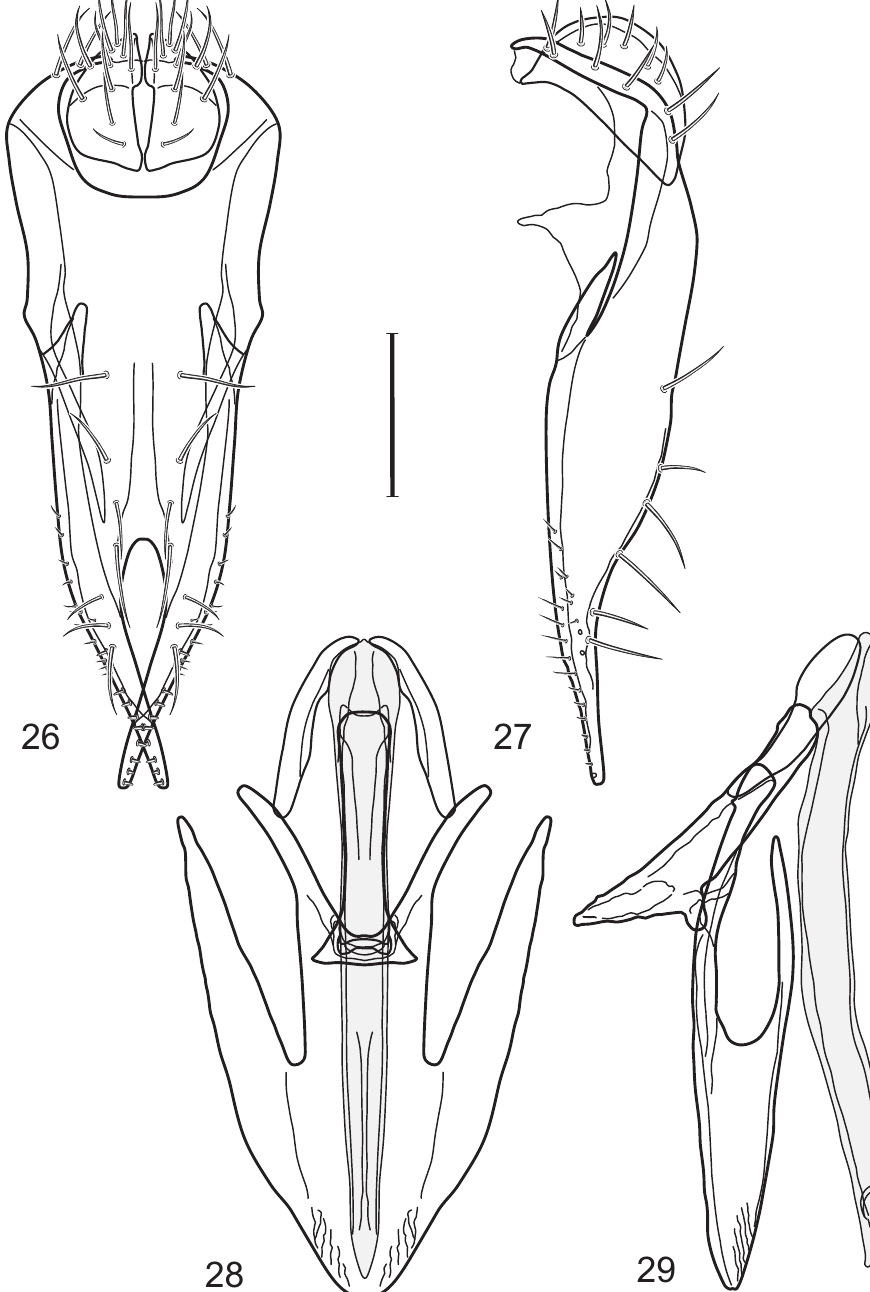
Figures 26–29. Hydrochasma patens Cresson (Chile. Talca: Rio Lircay, 11 km N Talca) 26 epandrium and cerci, posterior view 27 same, lateral view 28 internal structures of male terminalia (aedeagus [shaded], phallapodeme, gonite, hypandrium), ventral view 29 same, lateral view. Scale bar = 0.1